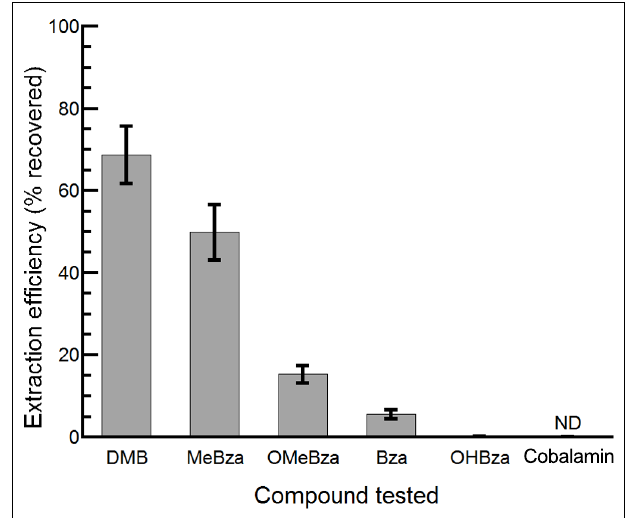
FIGURE 5 | Efficiency of extraction of benzimidazoles and cobalamin. The percent recovery following extraction and purification of the indicated compounds is shown. Bars represent the average of three replicates, and error bars represent the SE. ND, not detected, limit of detection was 5